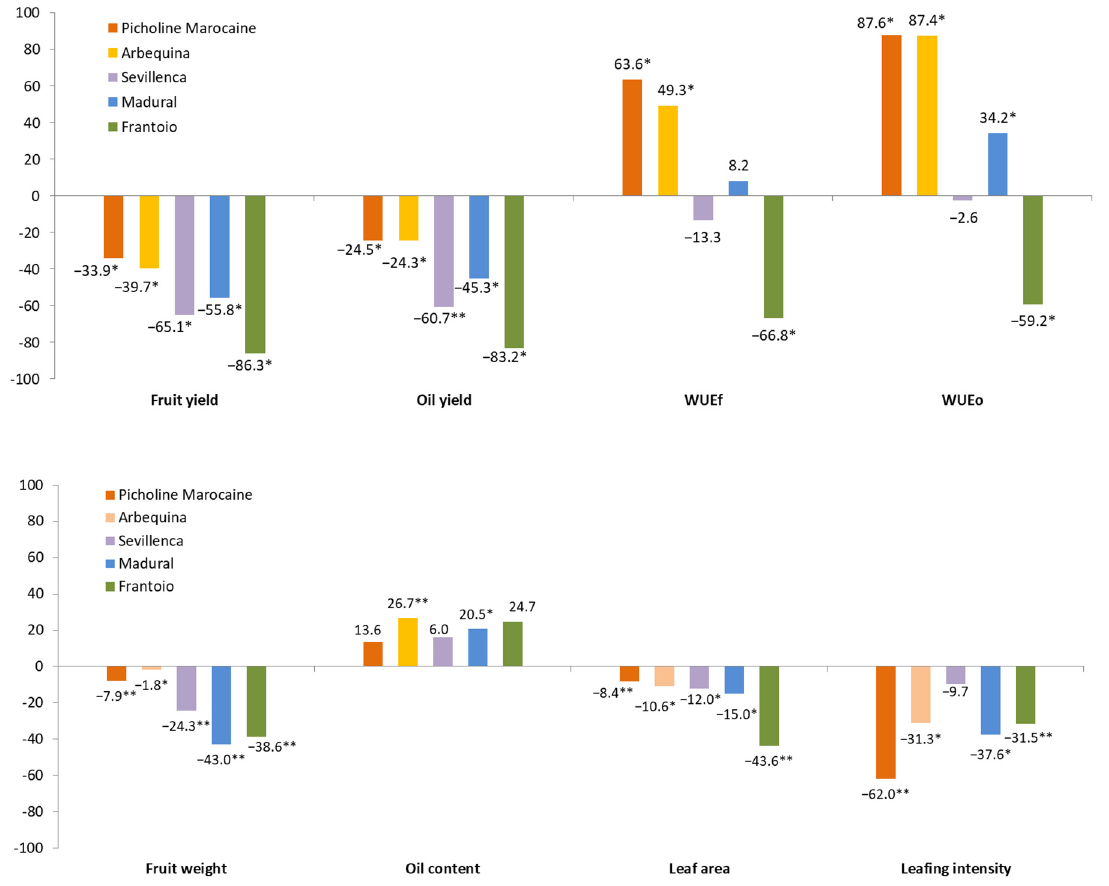
Figure 1. Response of Picholine Marocaine, Arbequina, Sevillenca, Madural, and Frantoio to applied water stress (averages for two experimental years 2019 and 2020). *,**: significant decrease/increase at p < 0.05 or p < 0.01, respectively; WUE: water use efficiency for fruit (WUE f ) and oil production (WUE o ).